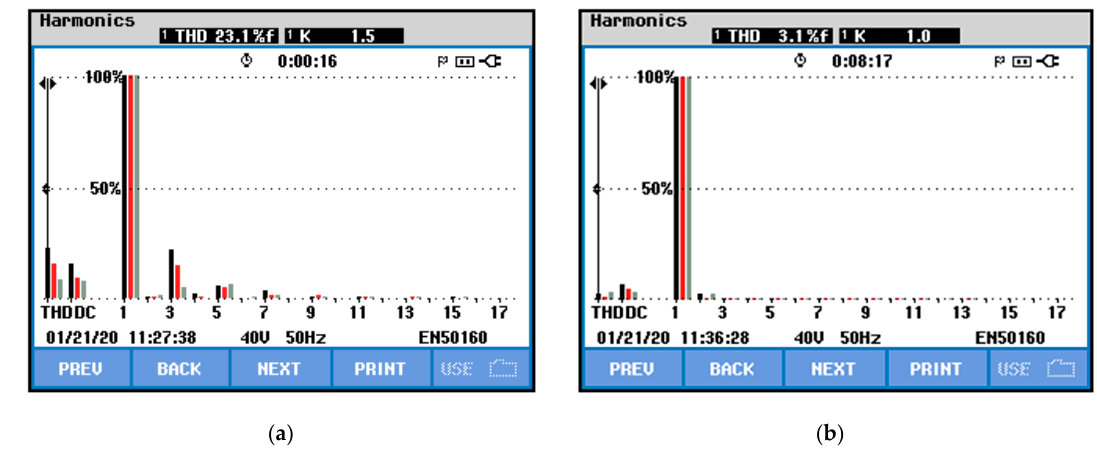
Figure 20. Frequency spectrum of the three-phase currents at the secondary windings of the V/V transformer (when two load sections are loaded): ( a ) before compensation; ( b ) after compensation.